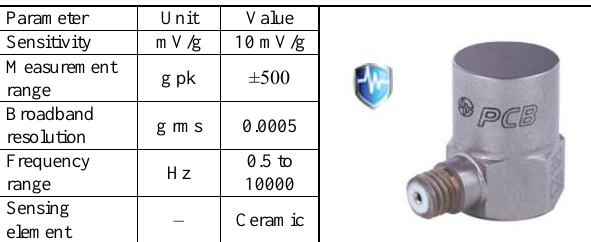
Table 1. Features of the PCB352C03 sensor [14]